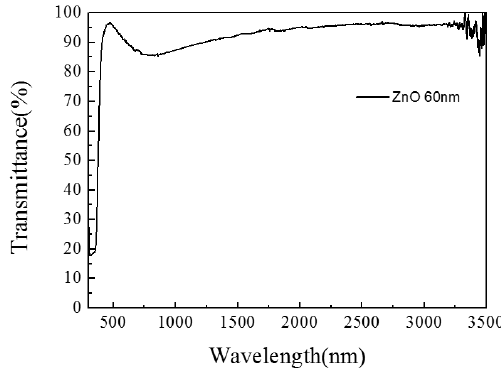
Figure 1. The transmittance diagram of ZnO/glass complex films for different thickness.